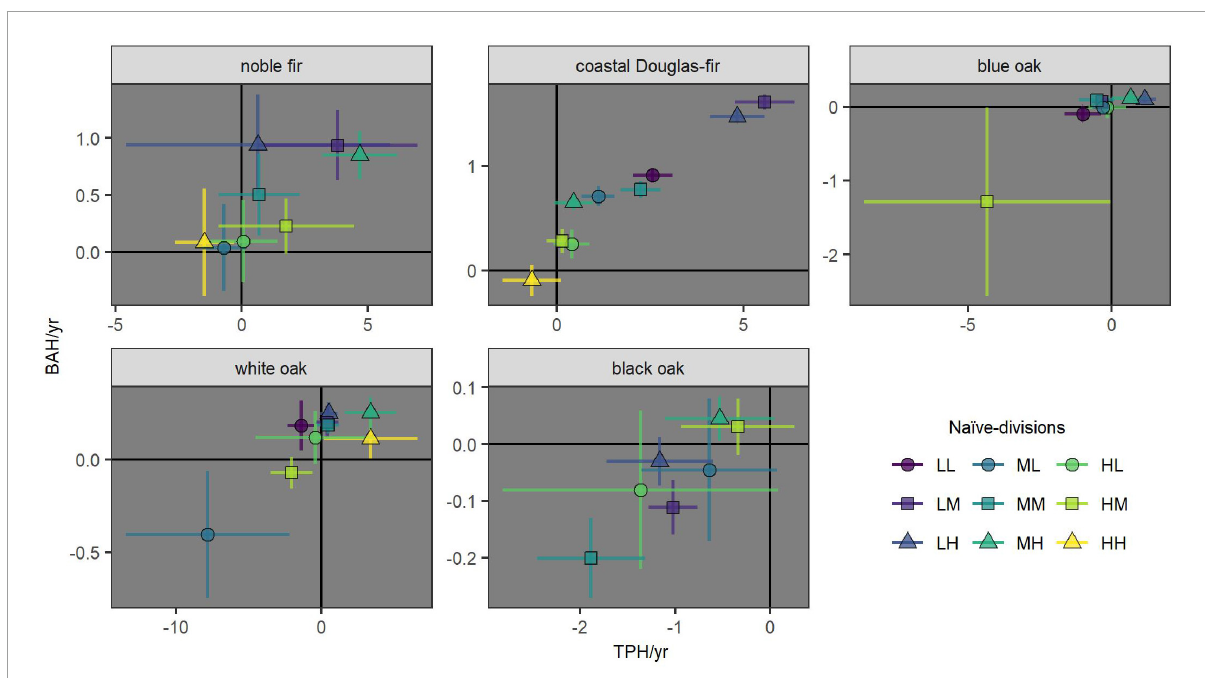
FIGURE3 Estimates and equal-tailed 90% confidence intervals for net-growth within naïve-divisions of habitat (based on elevation and latitude; naïve-divisions) in terms of the BAH/year and TPH/year on forest land where the species was present. The first and second letters of the naive-divisions code ( Table 2 ) correspond to the elevation- and latitude-partitions, respectively (e.g., LM for low-elevation and mid-latitude); see Table 2 for individual naïve-division definitions. A value of zero net-growth BAH/year or TPH/year is indicated by the black lines for